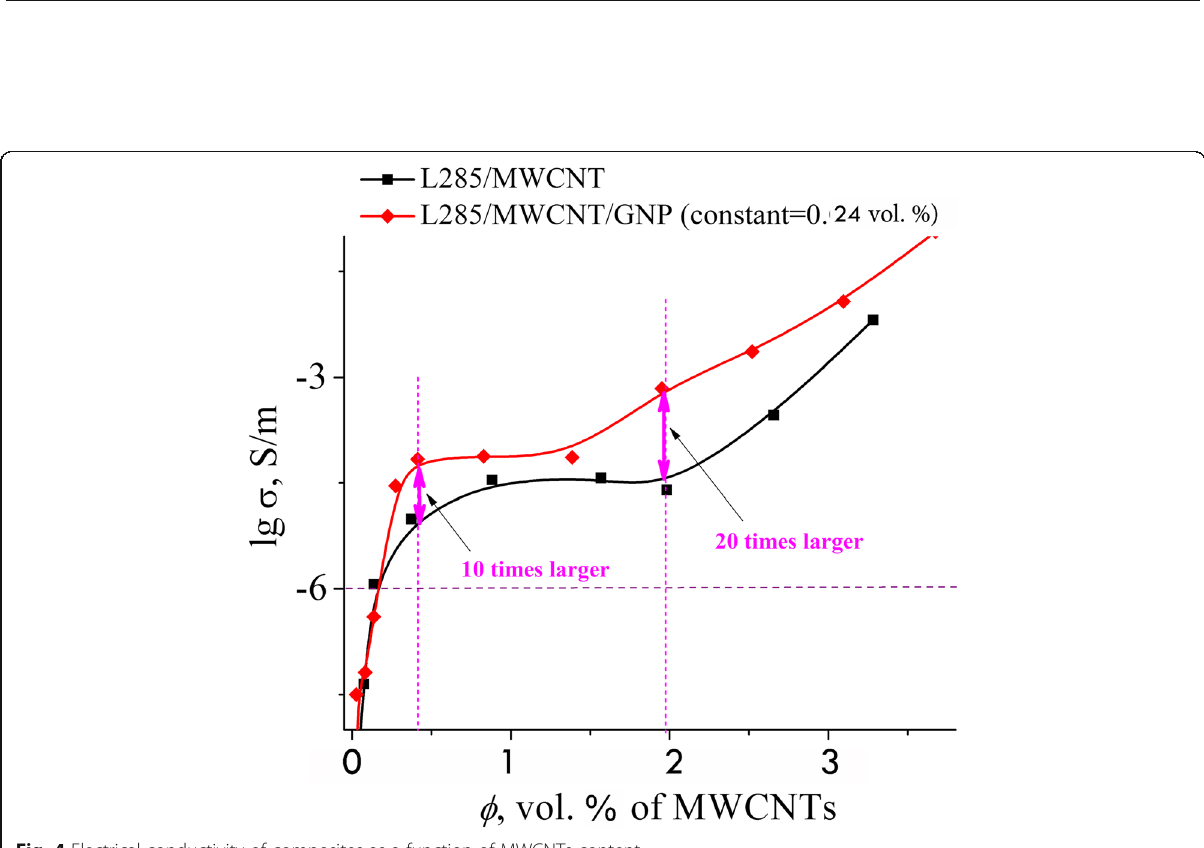
Fig. 4 Electrical conductivity of composites as a function of MWCNTs